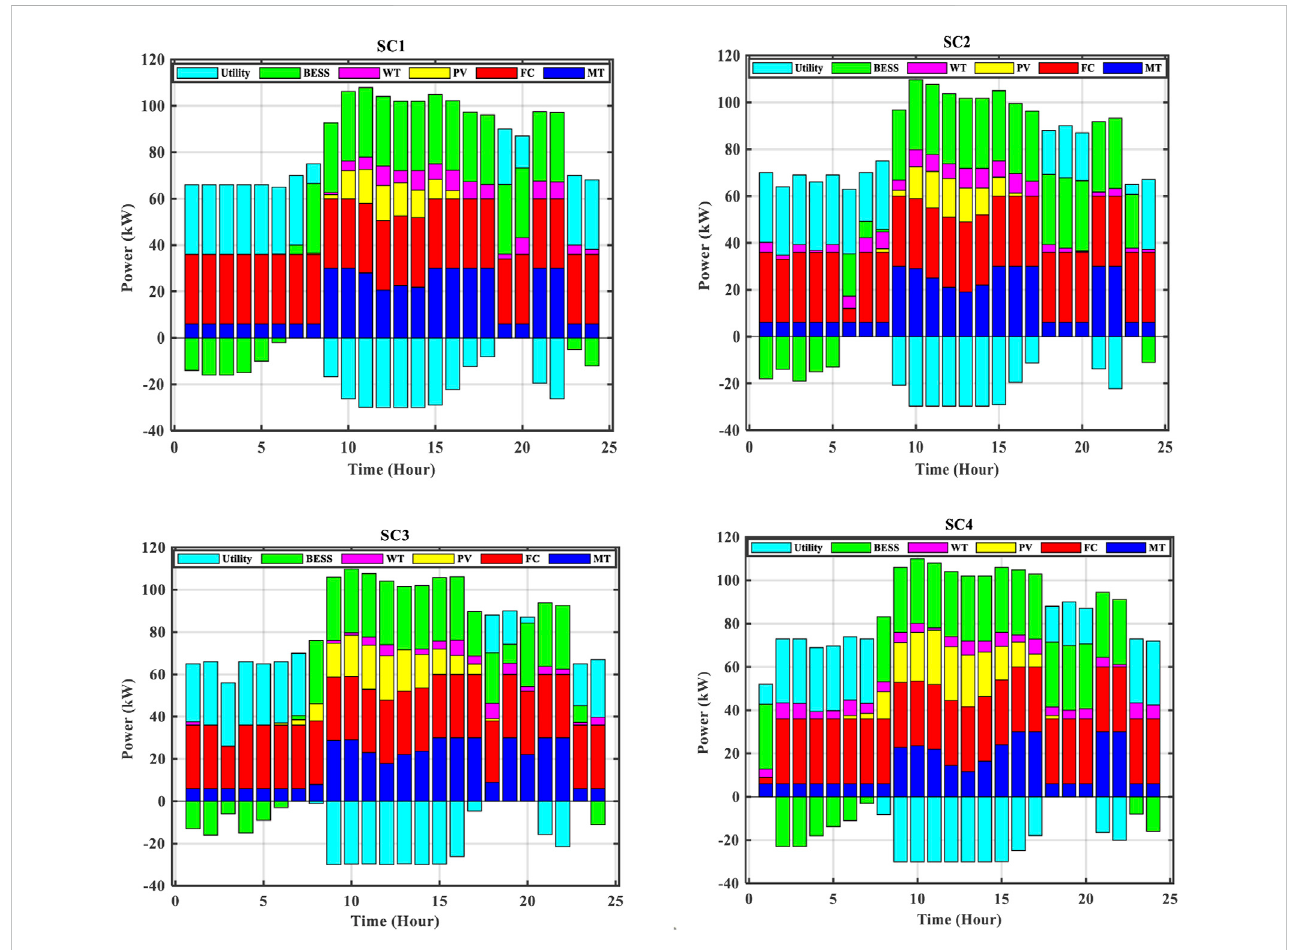
FIGURE 6 Case1 with scenarios